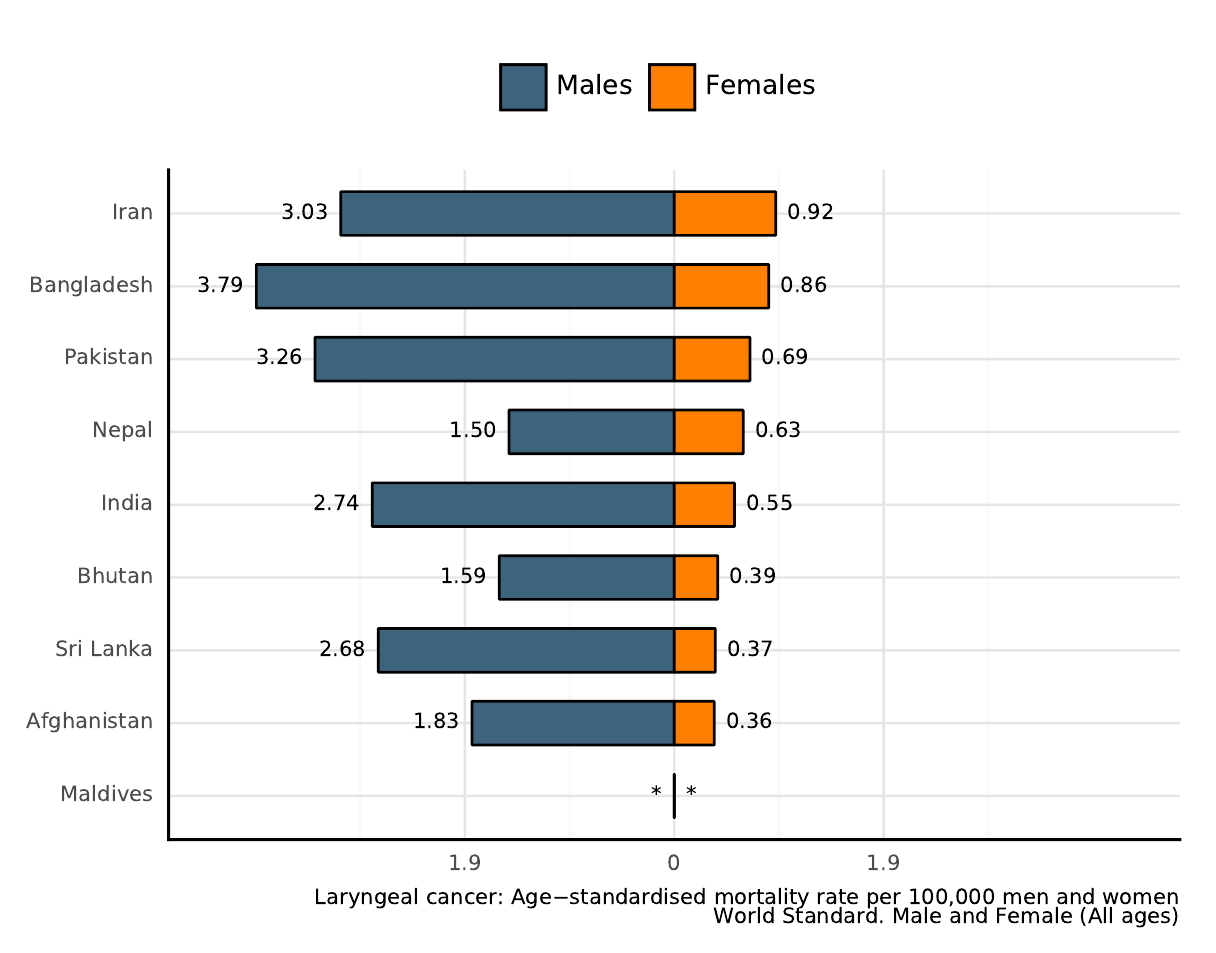
Figure 132: Age-standardised mortality rates of laryngeal cancer of India (estimates for 2020)